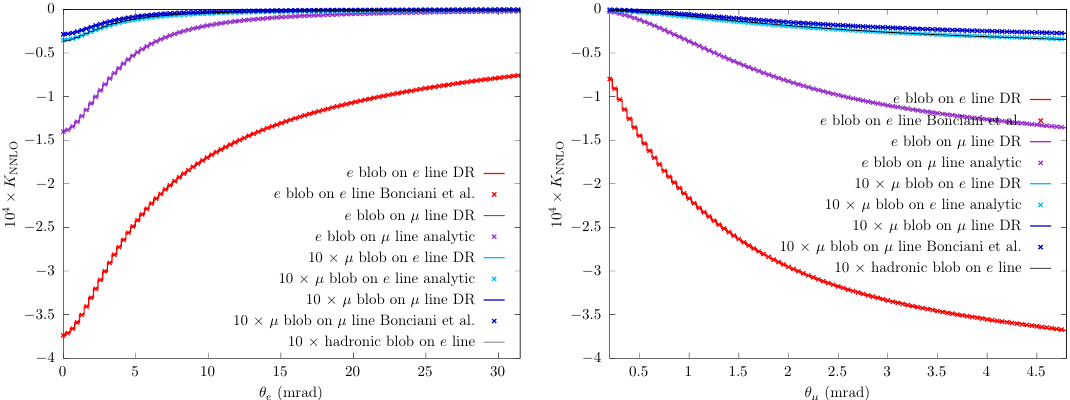
Figure 11. Left: effect of the diagrams of figure 5 on the θ e distribution. The red histograms refer to the electron loop correction along the external electron line; the violet histograms show the effects of the electron loop correction along the external muon line; the light blue refer to the muon loop along the external electron line; the dark blue line represents the muon loop along the external muon line; the black line gives the hadronic loop contribution along the external electron line. Right: the same as left panel, for the θ distribution. Notice that contributions due to muon or µ hadronic VP insertion have been amplified by a factor of 10 for readability on the scale of the plots.